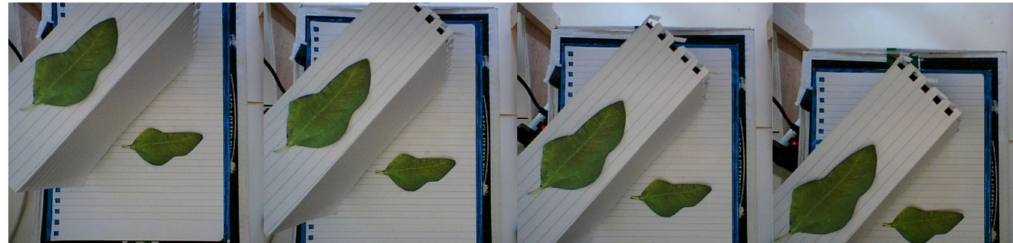
Figure 6. A sample of the pictures taken by the camera that will be used for leaf position estimation. The spacing between each consecutive picture is constant, and the camera is moved in a straight line. Initial tests involved manually positioned printed leaves so the maximum expected accuracy with the current method could be